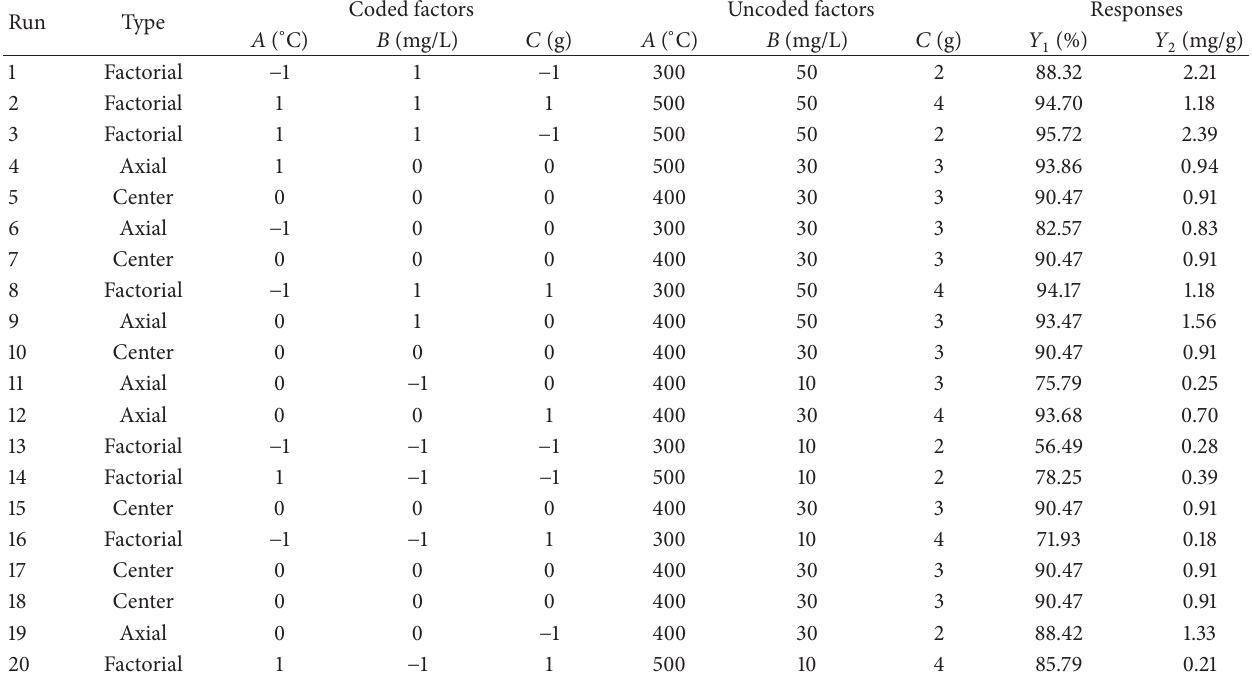
Table 1: Design matrix for the factors and respective response from